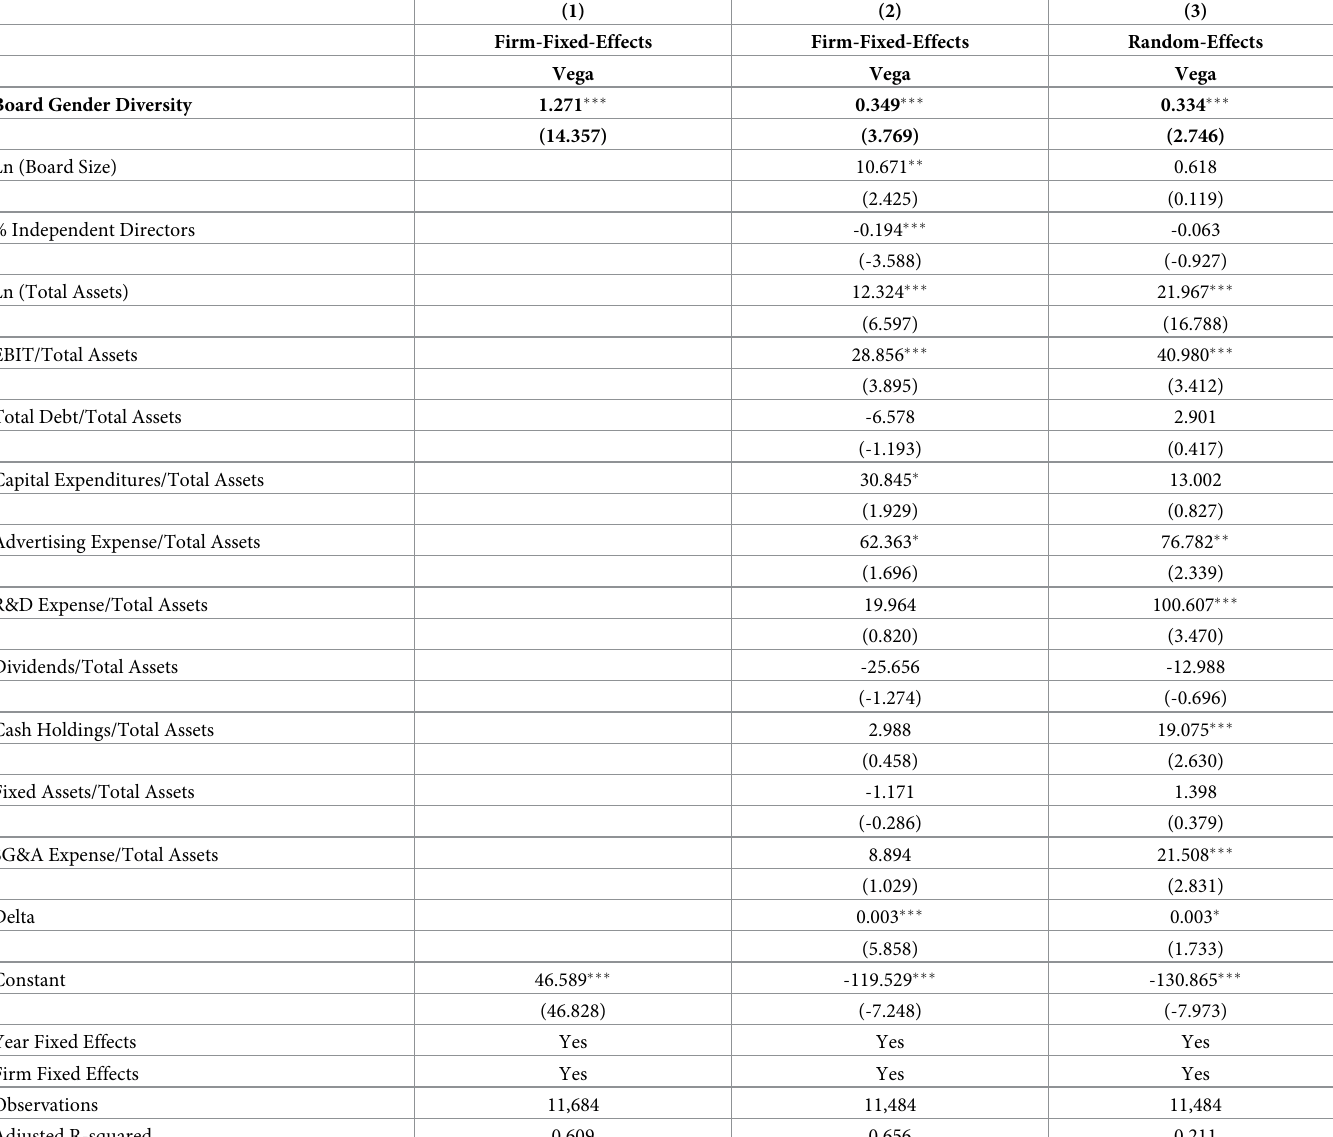
Table 2. The effect of board gender diversity on executive risk-taking